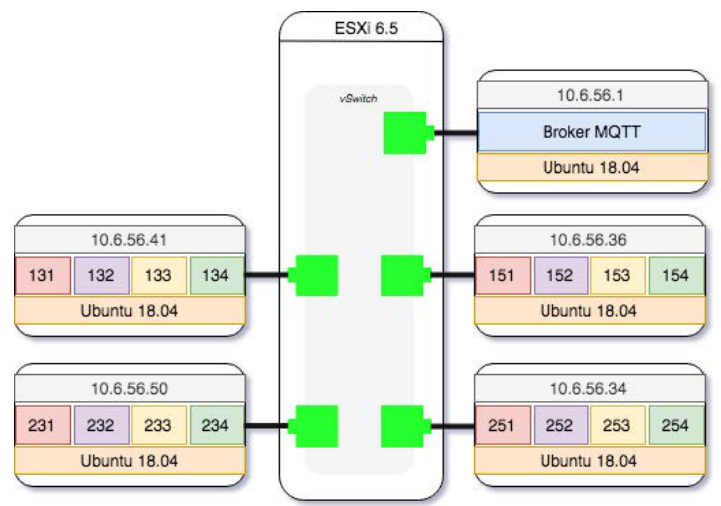
Figure 6. Virtual